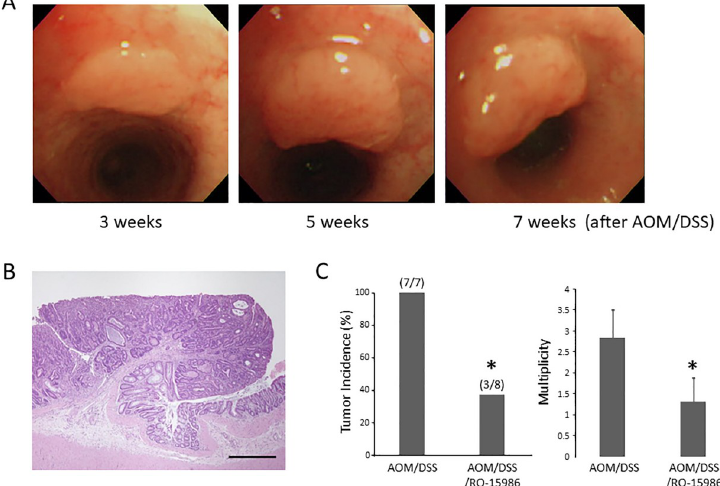
Fig 2. The images of AOM/DSS-induced colon tumors and the effects of RQ15986 on the tumors in KAD rats. Endoscopic (A) and histopathological (B) observations of colon tumors in AOM/DSS-treated KAD rats. (A) Endoscopic images of a colon tumor of 3, 5, and 7 weeks after AOM/DSS administration on the left, center, and right panel, respectively. (B) Hematoxylin and eosin-stained tumor. Scale bar, 500 μ m. (C) Incidence and multiplicity of colon tumors. Each column represents the mean ± SD. Asterisk indicates statistically significant difference compared to AOM/DSS group; P < 0.05.